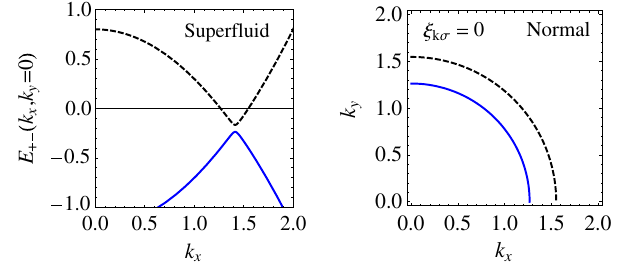
FIG. 1. (Left) Superfluid: Mean-field quasiparticle energies in the superfluid phase. (Right) Normal: Mismatched Fermi surfaces in the normal phase. The smaller, blue Fermi surface is taken to be the ↓ component, the larger, black-dashed Fermi surface belongs to the ↑ component. Here and in the rest of the paper, we use μ ¼ ð μ ↑ þ μ ↓ Þ = 2 as the average chemical potential and h ¼ ð μ ↑ − μ 2 as the average “ Zeeman ” field. We further define the mass ↓ Þ = ratio as r ¼ m ↓ =m ↑ . The Fermi momenta of the two species are ffiffiffiffiffiffiffiffiffiffiffiffiffiffiffiffiffiffi p ffiffiffiffiffiffiffiffiffiffiffiffiffiffiffiffiffiffiffi p 2 ð μ þ h Þ 2 r ð μ − h Þ and k . Here, we given by k F; ↑ ¼ F; ↓ ¼ use r ¼ 1 in units of m ↑ as appropriate for an equal-mass mixture, μ ¼ 1 , h ¼ 0 . 1 , and α ¼ 0 . 05 . The superfluid “ gap ” α opens away from the Fermi surfaces [18,19] (where the black-dashed line E þ crosses